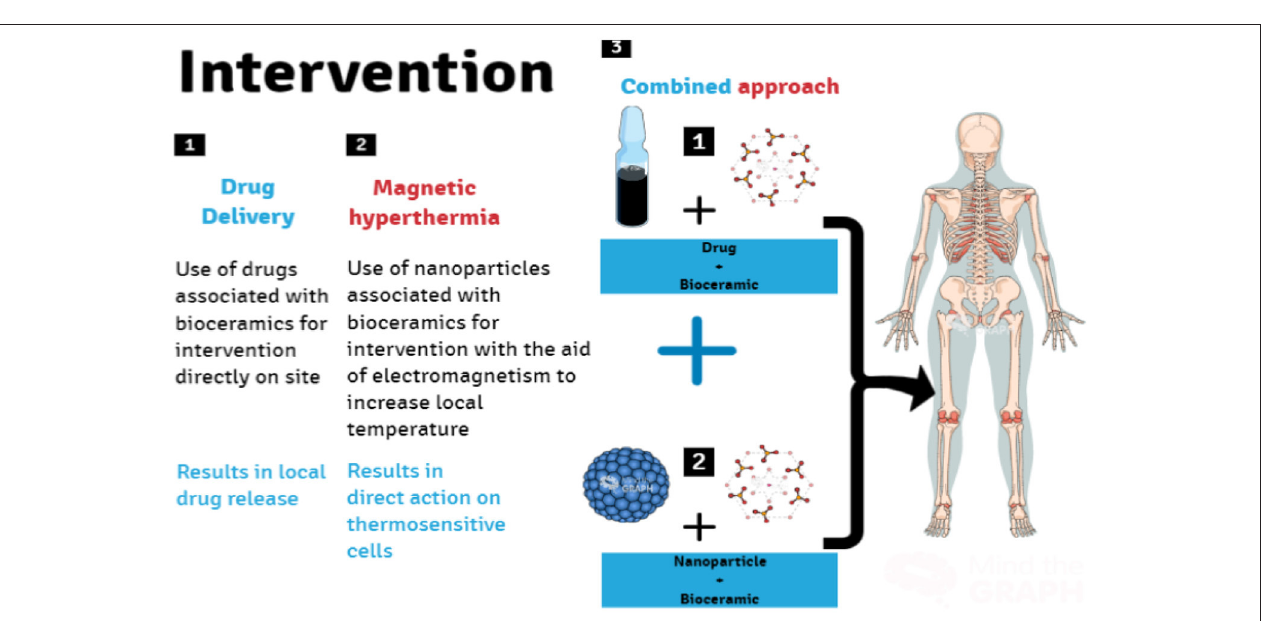
FIGURE 4 | Research fronts for in loco intervention using bioceramics nanocomposites for osteosarcoma treatment. Bioceramics scaffolds as drug delivery systems for the anti-tumor drug(s) (1), scaffolds with MNPs (2), as well as scaffolds combined with the anti-tumor drug(s) and MNPs (3) (Image Source: created using Mind the